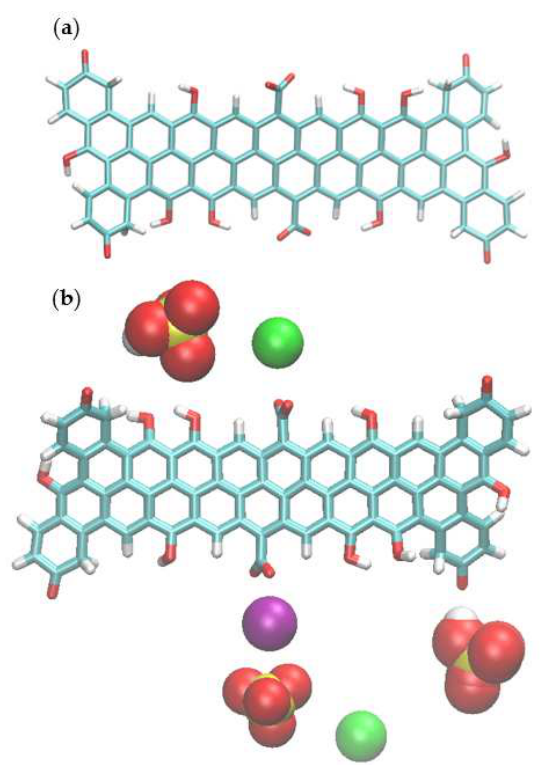
Figure 1. Proposed simplified surface model of ( a ) SAC600 3/1 ( b ) and ions around model activated carbon in the solution of activated carbon HCrO 4- , CrO 42- and MgCl 2 . Colour coding: carbon cyan, oxygen red, potassium ions (K + ) green, magnesium ion (Mg 2+ ) purple, hydrogen white and chromium yellow.